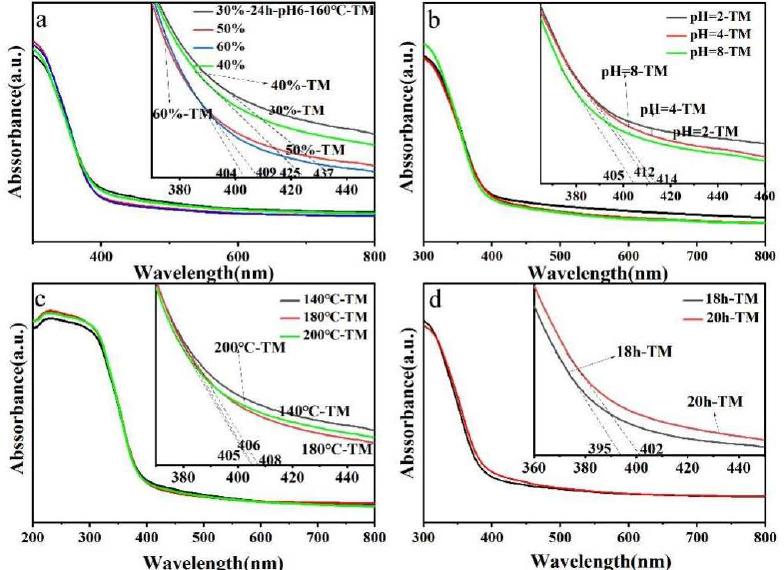
Figure 12. Ultraviolet-visible absorption spectra of TiO 2 –montmorillonite (MMT) prepared using ( a ) different TiO 2 /MMT mass ratios at a reaction temperature of 160 °C, a dwelling time of 24 h, and a pH of 6; ( b ) different pH levels with a reaction temperature of 160 °C, a dwelling time of 24 h, and a TiO 2 content of 30 wt%; ( c ) different reaction temperatures with a dwelling time of 24 h, a pH of 6, and a TiO 2 mass ratio of 30 wt%; and ( d ) different dwelling times at a reaction temperature of 160 °C, a pH of 6, and a TiO 2 mass ratio of 30 wt%. Inset images show expansions of the 370–450 nm region.